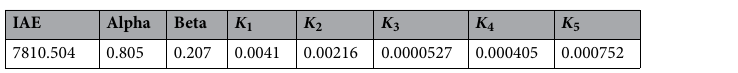
Table 7. PSO Optimization